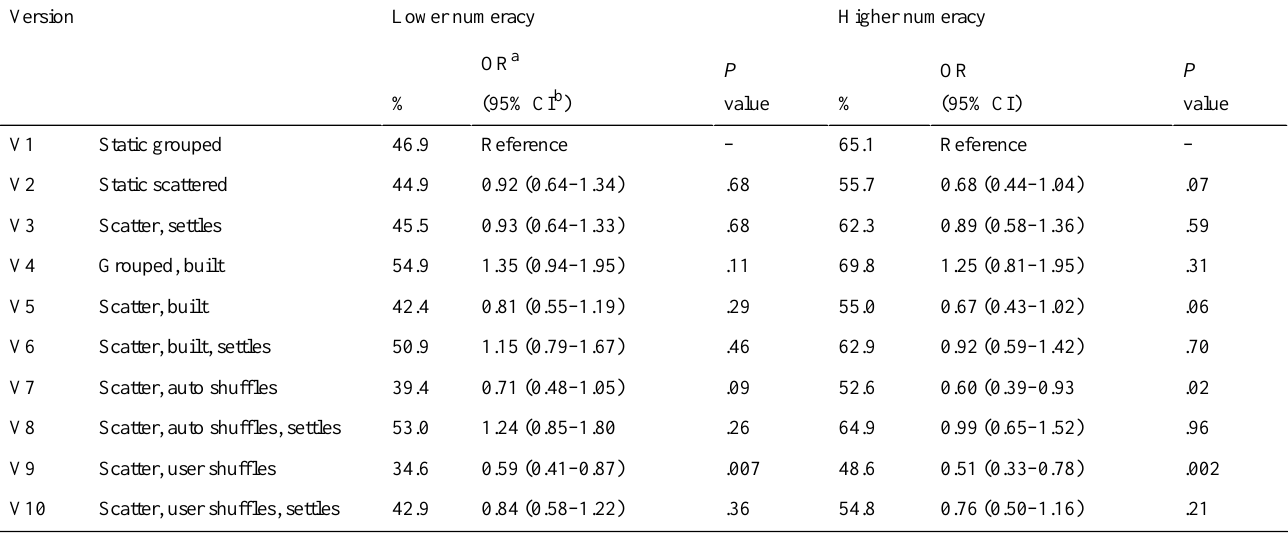
Table 5. Percentage correctly identifying the treatment with the higher risk of mouth and throat problems, by graph version and respondent numeracy.